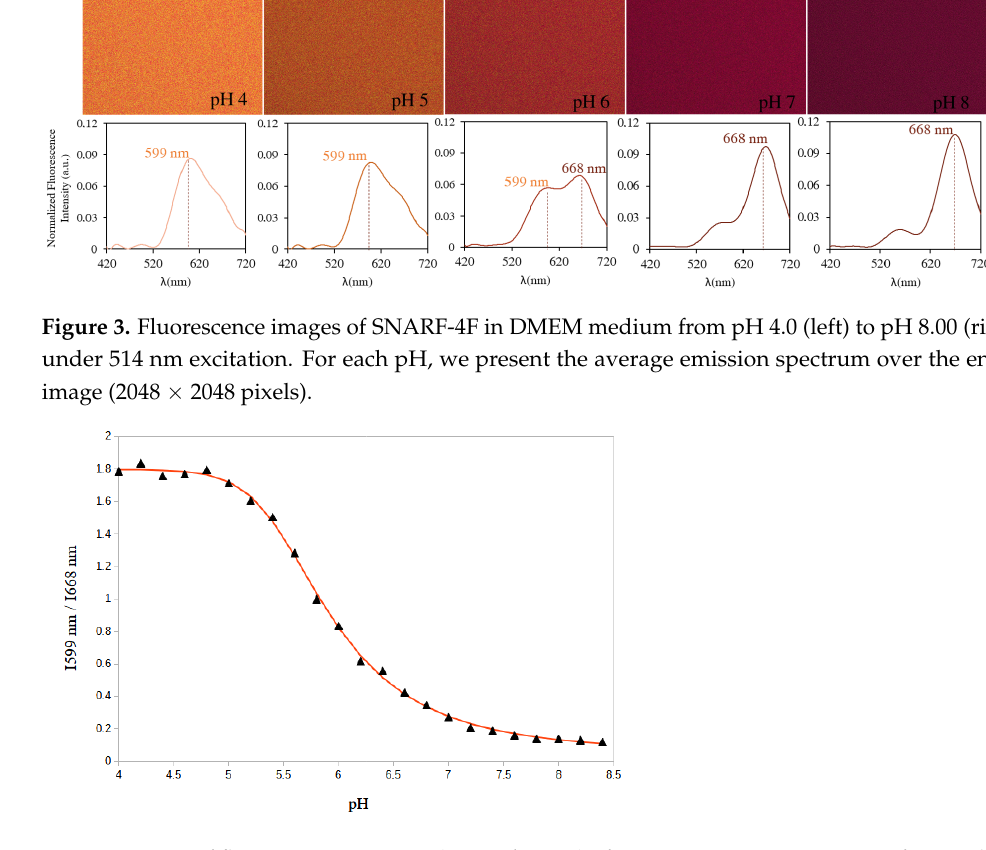
Figure 4. Ratio of fluorescence intensity (I 599nm /I 668nm ) of SNARF-4F in DMEM serum-free medium at different pH values. The experimental points are fitted with a logistic regression function (continu- ous line) for which R 2 =